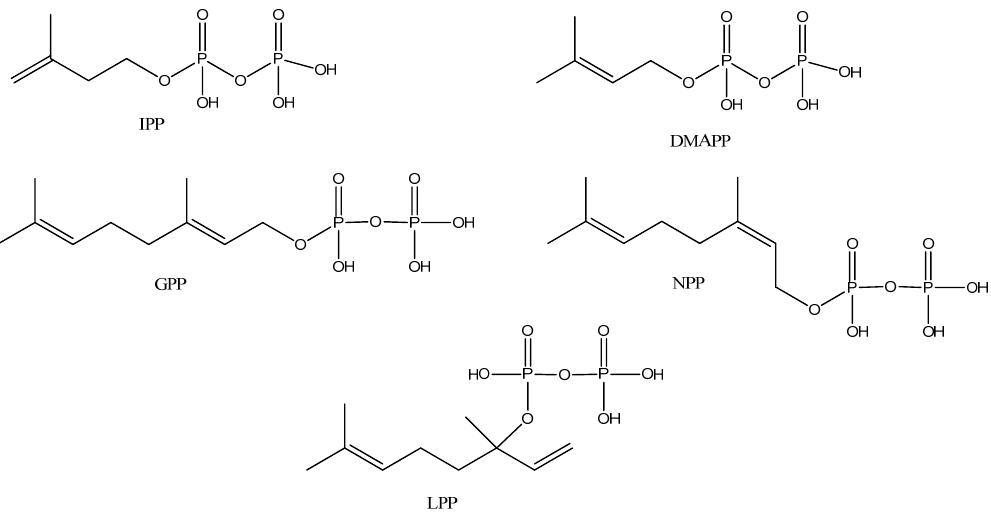
Figure 2. Structures of isopentenyl pyrophosphate (IPP), dimethylallyl pyrophosphate (DMAPP), geranyl pyrophosphate (GPP), neryl pyrophosphate (NPP) and linaloyl pyrophosphate (LPP) which are all possible precursors to monoterpenes from A.annua